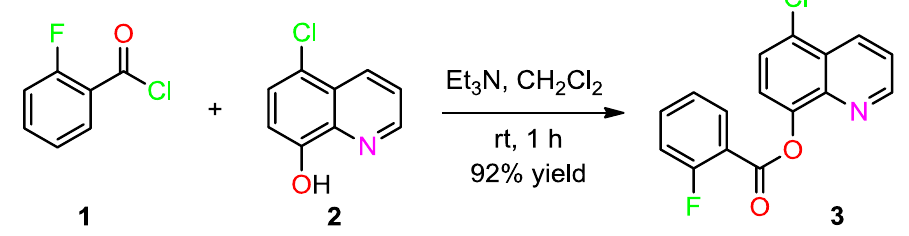
Figure 1. Oak Ridge Thermal Ellipsoid Plot (ORTEP) drawing of the asymmetric unit for compound 3 ; ellipsoids are displayed at the 50% probability level.